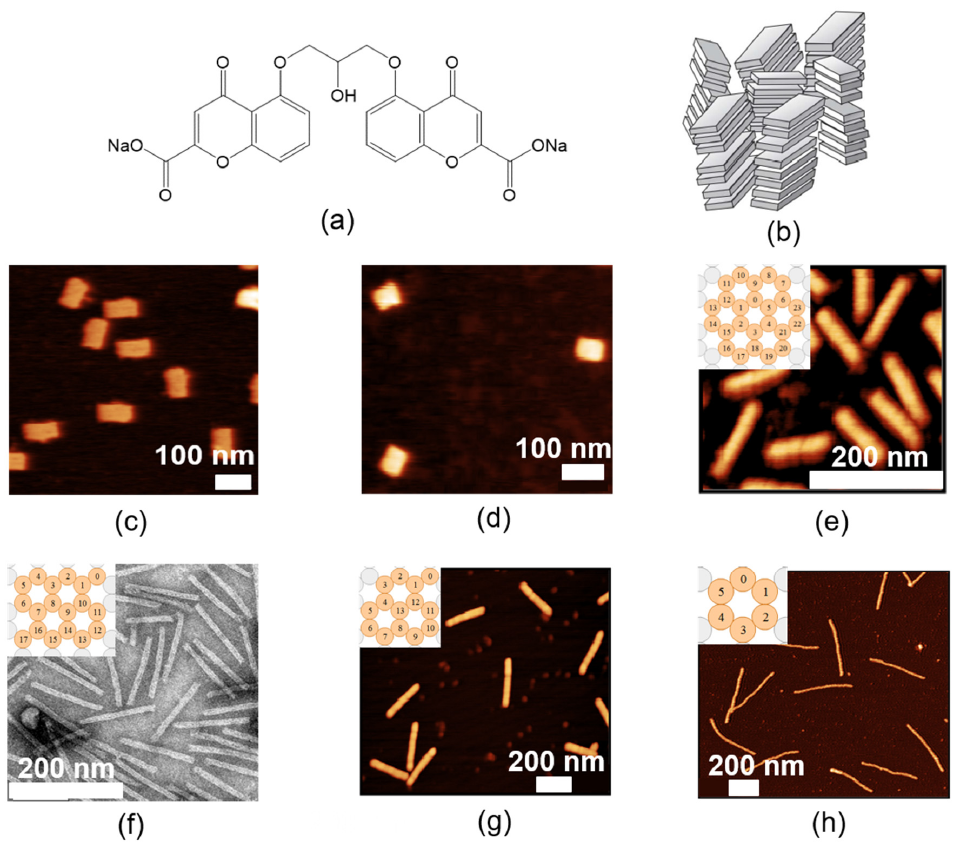
Figure 1. Compounds and nanostructures used in this study. ( a ) Chemical structure of the Disodium cromoglycate (DSCG) molecule. ( b ) Structure of the chromonic N phase [41], which consists of columnar molecular aggregates that are orientationally ordered. ( c – e ), ( g , h ) Atomic force microscope (AFM) images and ( f ) transmission electron microscopy (TEM) image of ( c ) 1LS (layer sheets), ( d ) 2LS, ( e ) 24HB (helix bundles), ( f ) 18HB, ( g ) 14HB and ( h ) 6HB, respectively.